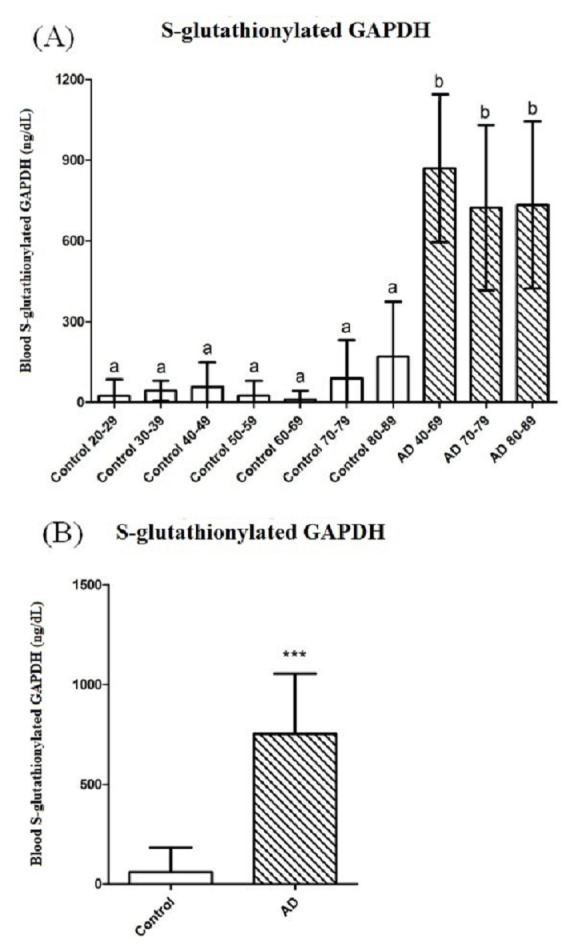
At different ages, the blood S-glutathionylated GAPDH levels of the patients with AD were higher than those of the controls.(A) The controls were separated into the age ranges of 20–29 (n = 18), 30–39 (n = 3), 40–49 (n = 13), 50–59 (n = 32), 60–69 (n = 46), 70–79 (n = 56), and 80–89 years (n = 23), for comparison with the patients with AD aged 40–69 (n = 8), 70–79 (n = 18), and 80–89 years (n = 21). a, bDifferent letters indicate significant differences, as determined by one-way ANOVA (p < 0.001). (B) The comparison between the total set of controls aged 20–79 years (n = 191) and the total set of patients with AD aged 40–89 years (n = 47) showed significant differences (***p < 0.001).